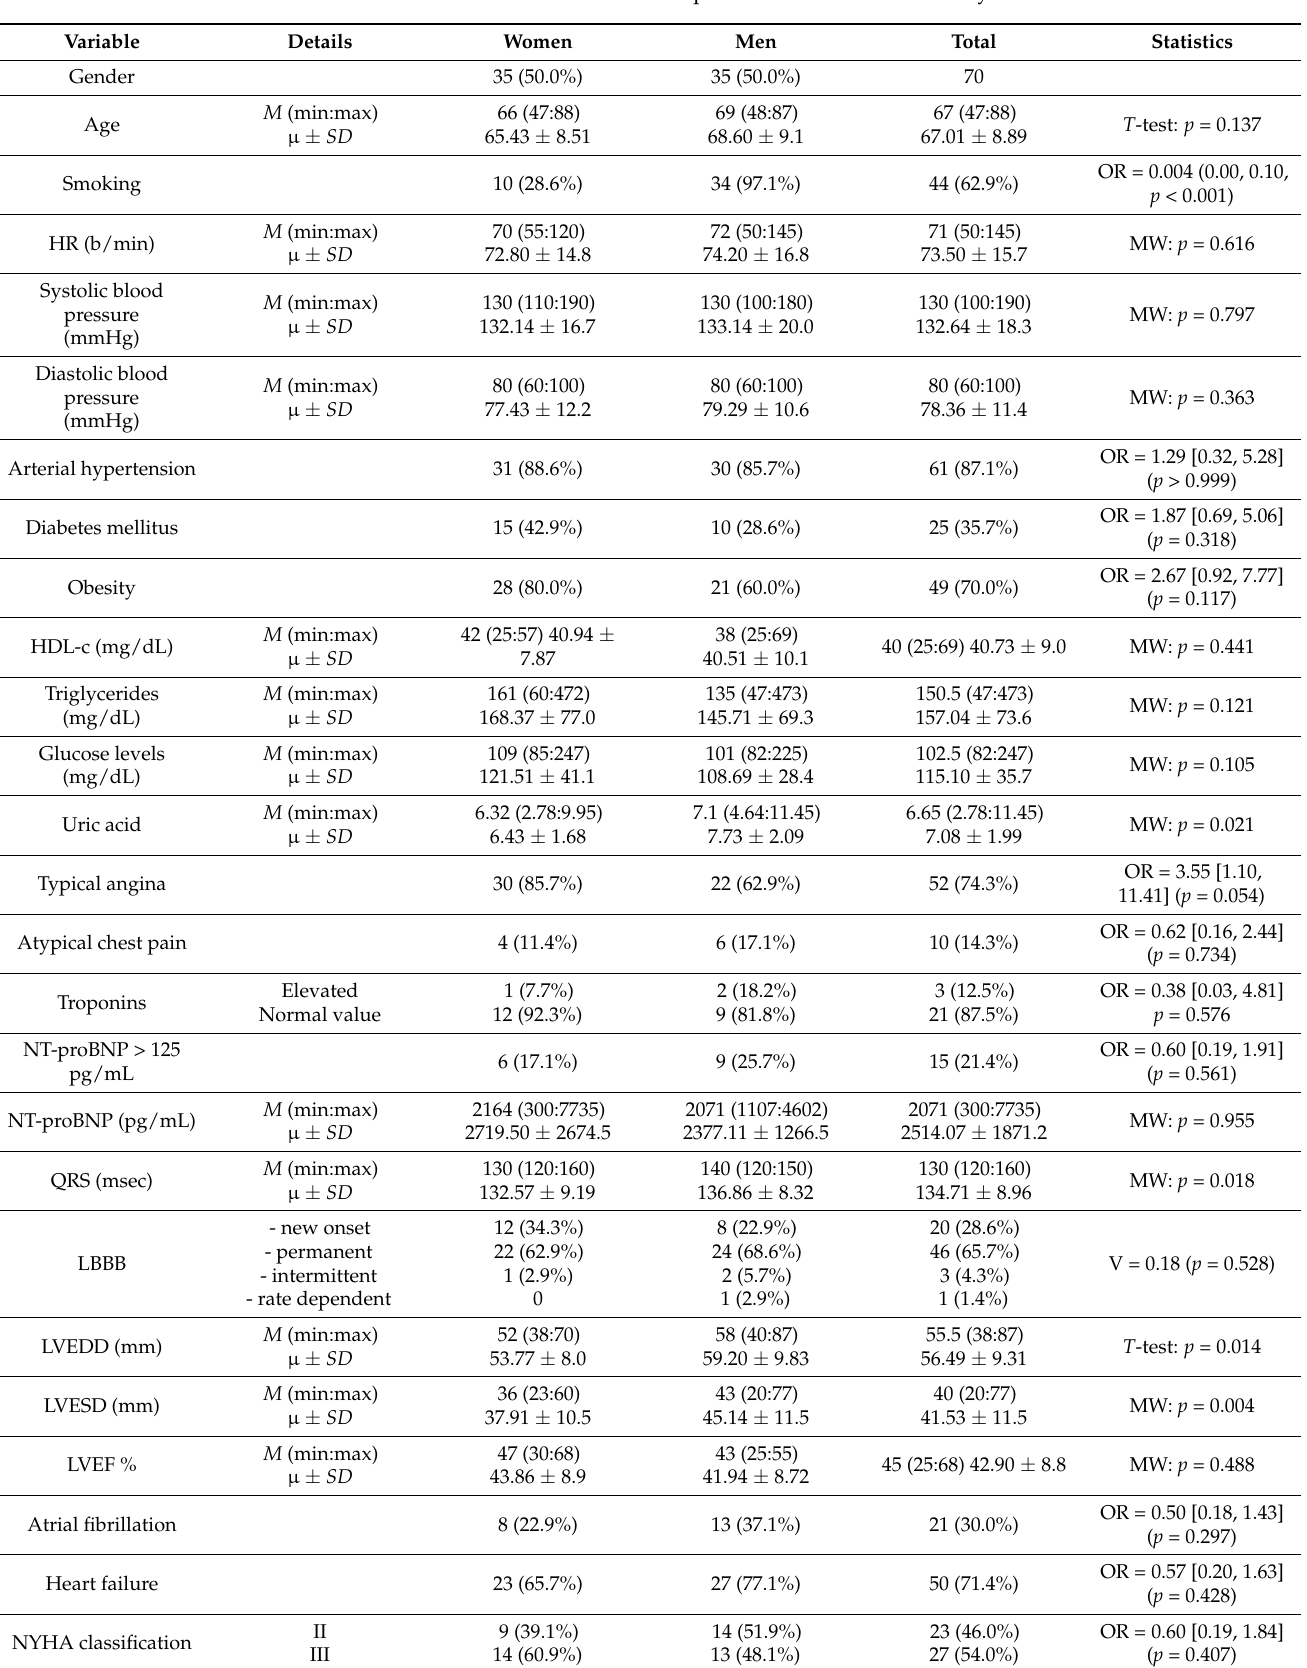
Table 1. The main characteristics of the patients included in the